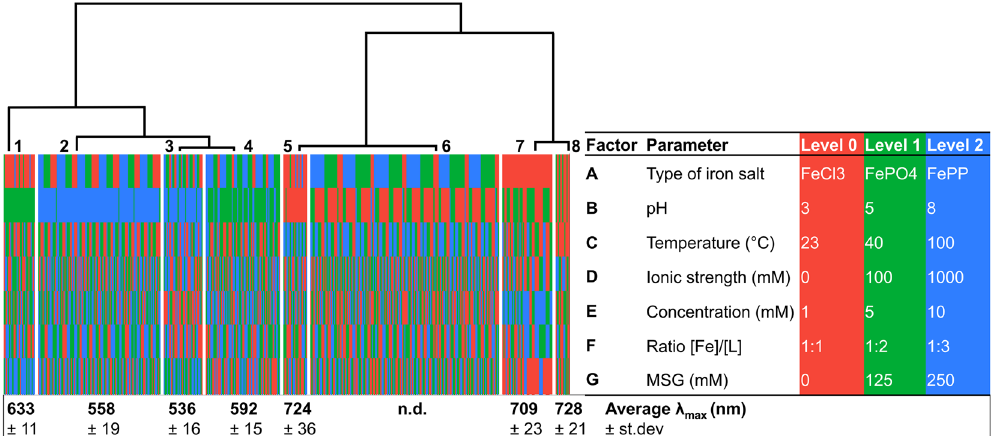
Figure 3. Dendrogram of samples hierarchically clustered based on the normalised absorbance spectra. The heatmap indicates the different levels of factors for each cluster as shown in the table. The average maximum absorbance wavelength ( λ max ) for each cluster is indicated below the heatmap. n.d. indicates that no LMCT band was